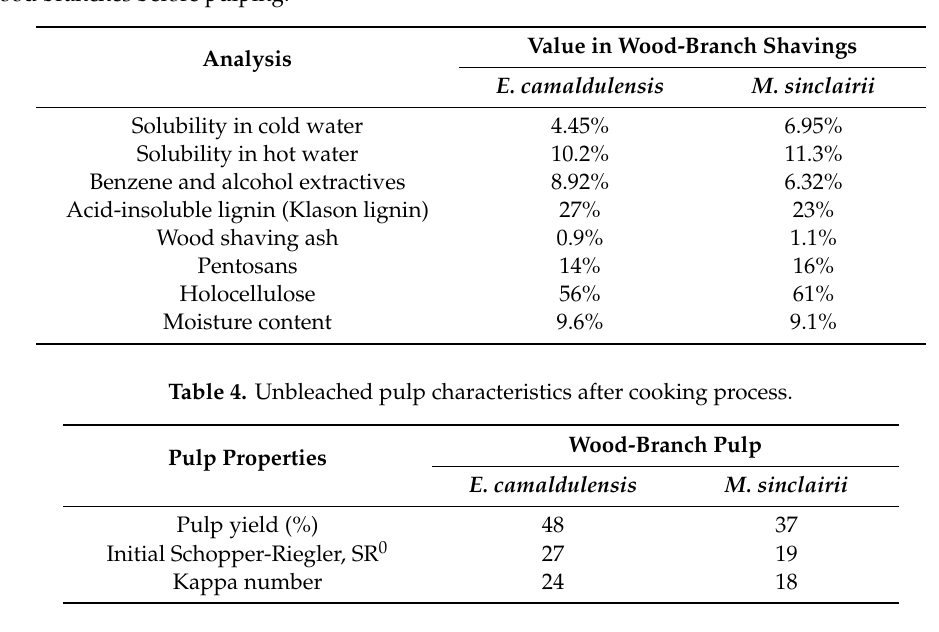
Table 3. Chemical and moisture content analyses of E. camaldulensis and M. sinclairii shavings from wood branches before pulping.